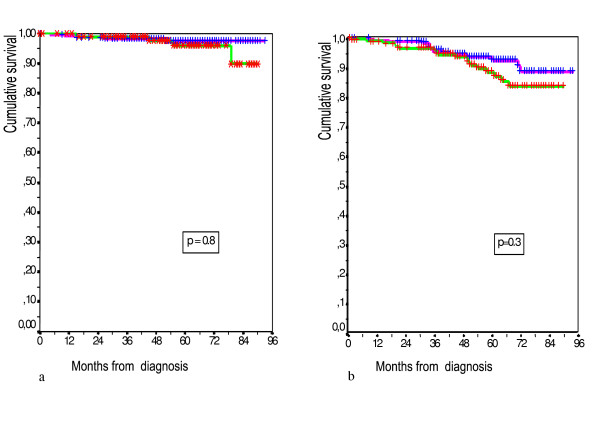
5-year survival of pT1a+b (3a) and pT1c (3b). 5-year OS values of pT1a+b (a) and pT1c (b) breast cancers between MSP participants and non-participants were equal to 98% and 96% (Log Rank = 0.76) respectively (a) and 93% and 89% (Log Rank = 1.57) respectively (b). [ = MSP participants;  = MSP non-participants]